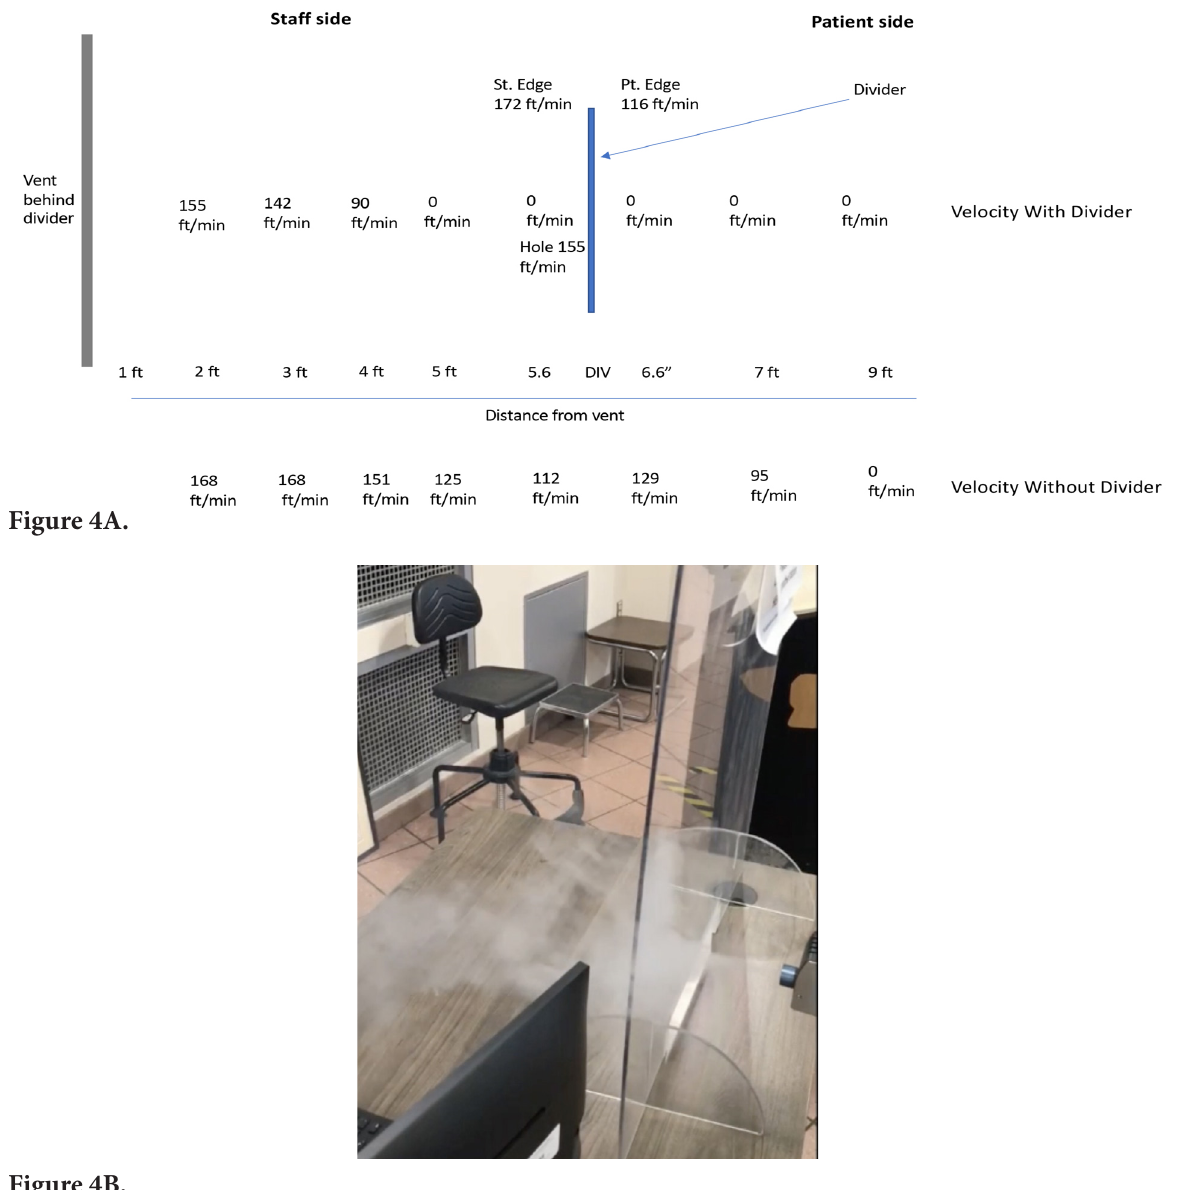
Figure 4. Airflow readings with versus without the plexiglass barrier in place for the 1 barrier (#10) that resulted in increased aerosol particle exposure (A) and a video demonstrating movement of condensed moisture fog into the space immediately behind the ineffective barrier (B). For the video illustration, the fog-generating device was placed closer to the edge of the barrier than the point of aerosol release because that provided a clearer illustration as the fog dissipated less than when released at a greater